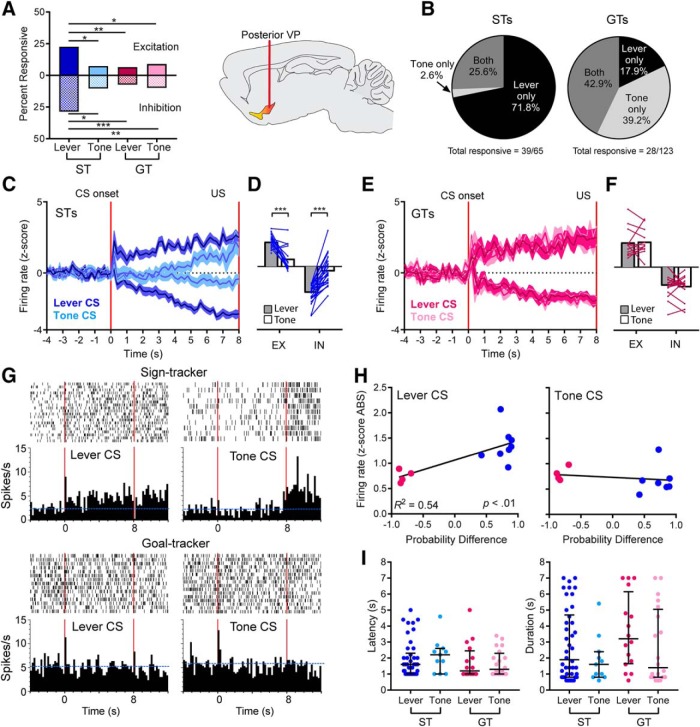
Posterior VP. Sign-tracking to the lever elicited greater neural responses than goal-tracking to either the lever or the tone. Cells were considered responsive to cue exposure if they showed a sustained increase or decrease in firing during the last 7 s of the 8-s period when the CS was present. A, The percentage of cells that responded to cue exposure was significantly greater for the ST-Lever condition compared to the ST-Tone, GT-Lever, and GT-Tone conditions, and this was true for both excitatory and inhibitory responses (*, p < 0.05; **, p < 0.01; ***, p < 0.001). B, In STs, most neurons responded only to the lever-CS and not the tone-CS; however, in GTs, responses were split more equally between the lever, the tone, or both. C, In STs, the magnitude (mean ± SEM) of the cue-induced change in neural activity in responsive cells was greater during lever-CS trials than tone-CS trials. D, In STs, individual responsive cells (lines) showed significantly greater increases or decreases in firing during lever-CS trials compared to tone-CS trials (***, p < 0.001; gray and white bars represent mean firing rate; EX, excitation; IN, inhibition). E, F, For GTs, the magnitude of change in responsive cells (either excitatory or inhibitory) did not differ between lever-CS and tone-CS trials (E) and responsive cells showed no significant differences between lever-CS and tone-CS trials (F). G, Representative cells are shown for a ST (top) and GT (bottom). Blue horizontal dashed lines represent the baseline firing rate, and vertical red lines mark the beginning and end of the 8-s period when the cue was present. The ST cell showed greater cue-induced excitation in lever-CS trials (left) compared to tone-CS trials (right). An example GT cell showed no change during exposure to the lever or tone, although it did show a brief response to cue onset. H, In lever-CS trials, probability difference scores (i.e., the tendency to sign- or goal-track) were significantly correlated with the average change in firing rate for each rat. There was no significant correlation during tone-CS trials. I, No significant group differences were observed in the latency or duration of responses (figures show values for individual units, with median and interquartile ranges).